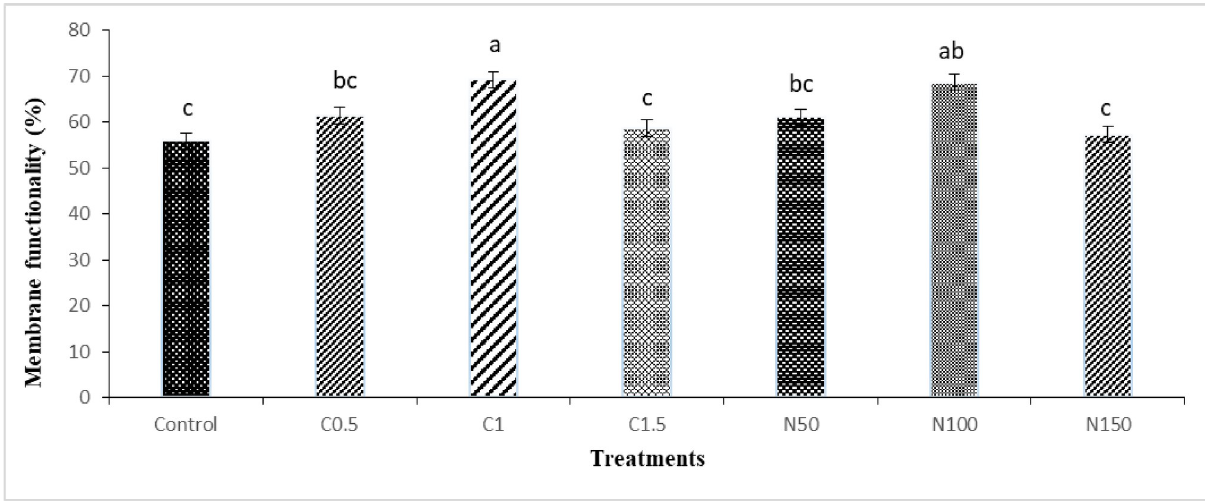
Fig 4. Effect of crocin and naringenin supplementation in cryopreservation medium on post-thawed membrane functionality (%, HOS-test) of rooster sperm. Beltsville extender without antioxidant (control), C0.5 (Beltsville extender with 0.5 mM crocin), C1 (Beltsville extender with 1 mM crocin), C1.5 (Beltsville extender with 1.5 mM crocin), N50 (Beltsville extender with 50 μ M naringenin), N100 (Beltsville extender with 100 μ M naringenin), N150 (Beltsville extender with 150 μ M naringenin).